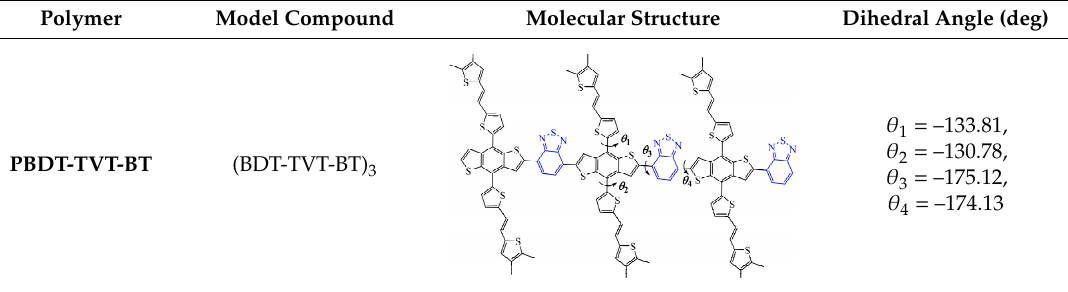
Figure 6. The optimized geometries and molecular orbital surfaces of the highest occupied molecular orbital (HOMO) and lowest unoccupied molecular orbital (LUMO) for the trimer model compound of PBDT-TVT-BT and PBDT-TVT-FBT. Table 2. Dihedral angles for the trimer models of PBDT-TVT-BT and PBDT-TVT-FBT obtained from density functional theory (DFT) at the B3LYP/6-31G* level.